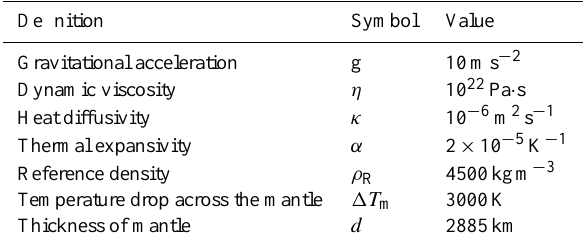
Table 1. Model constants. Table 2. Monitoring